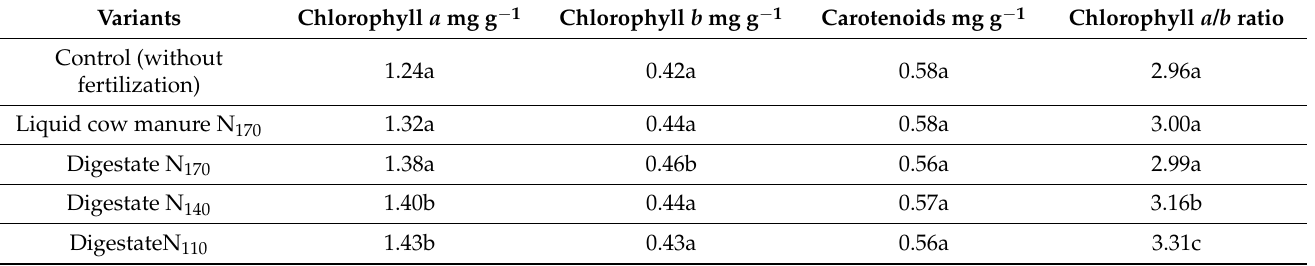
Table 3. The effect of digestate from liquid cow manure on photosynthetic parameters of spring